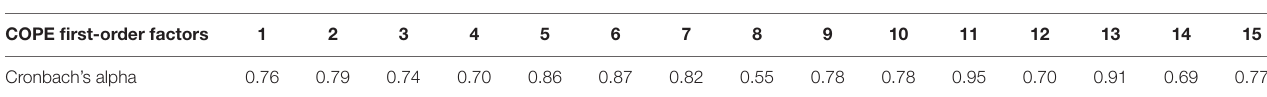
TABLE 3 | Reliability of the Slovak COPE Inventory. COPE first-order